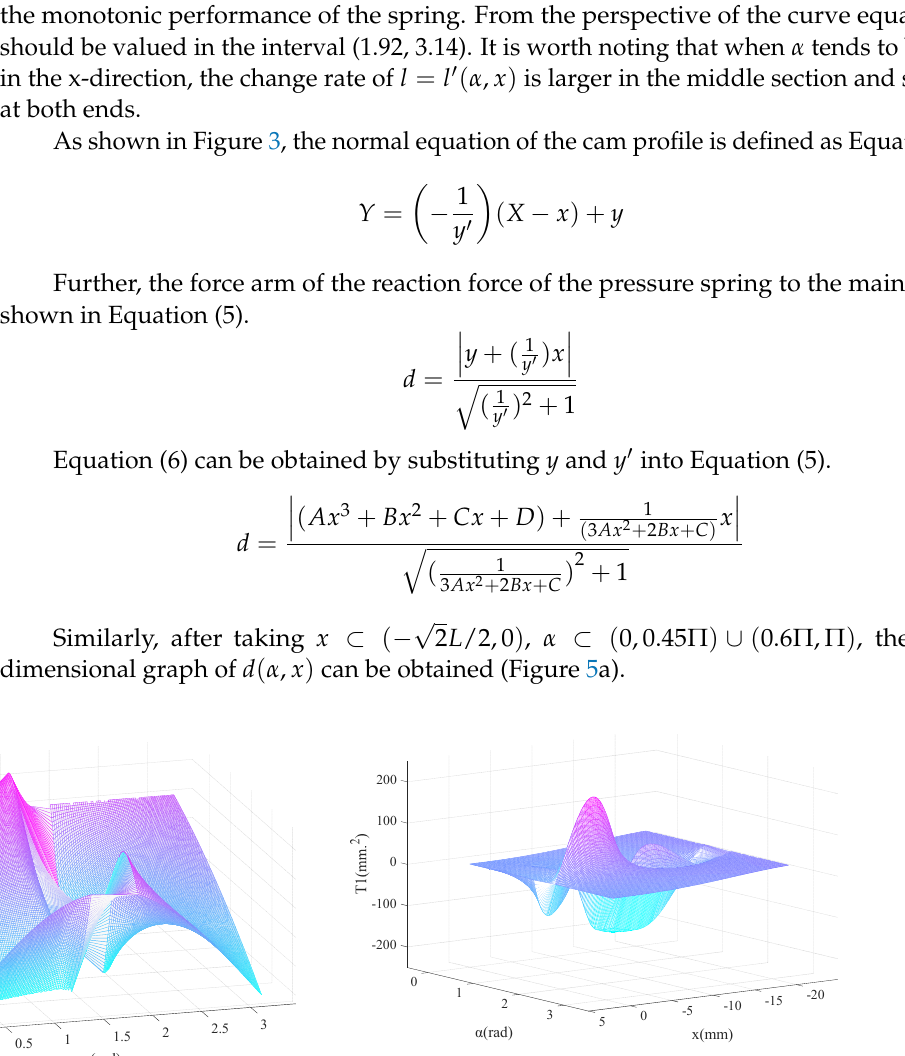
Figure 5. ( a ) Moment arm of the hip master cam; ( b ) three ‐ dimensional diagram of